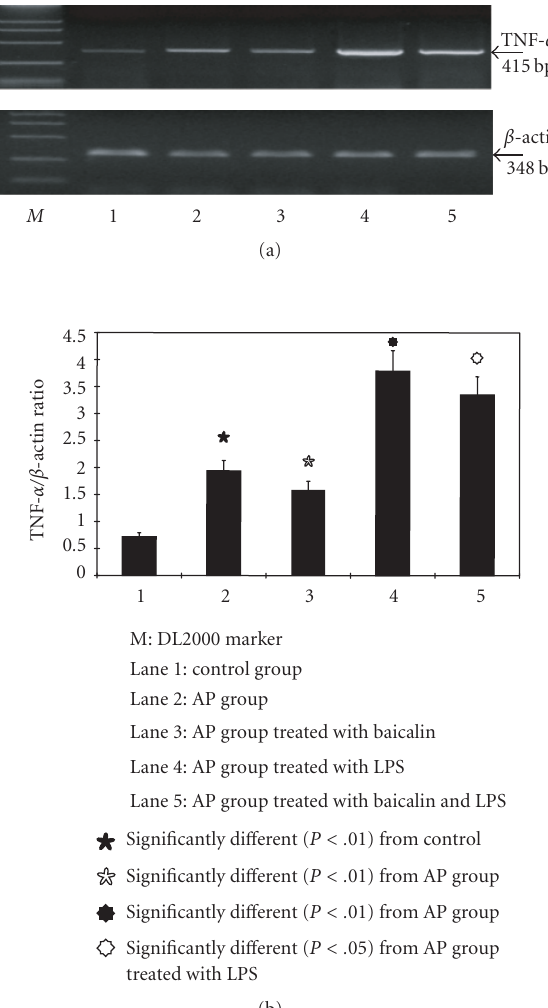
Figure 2: The mRNA expressions of TNF- α assessed with semi- quantitive